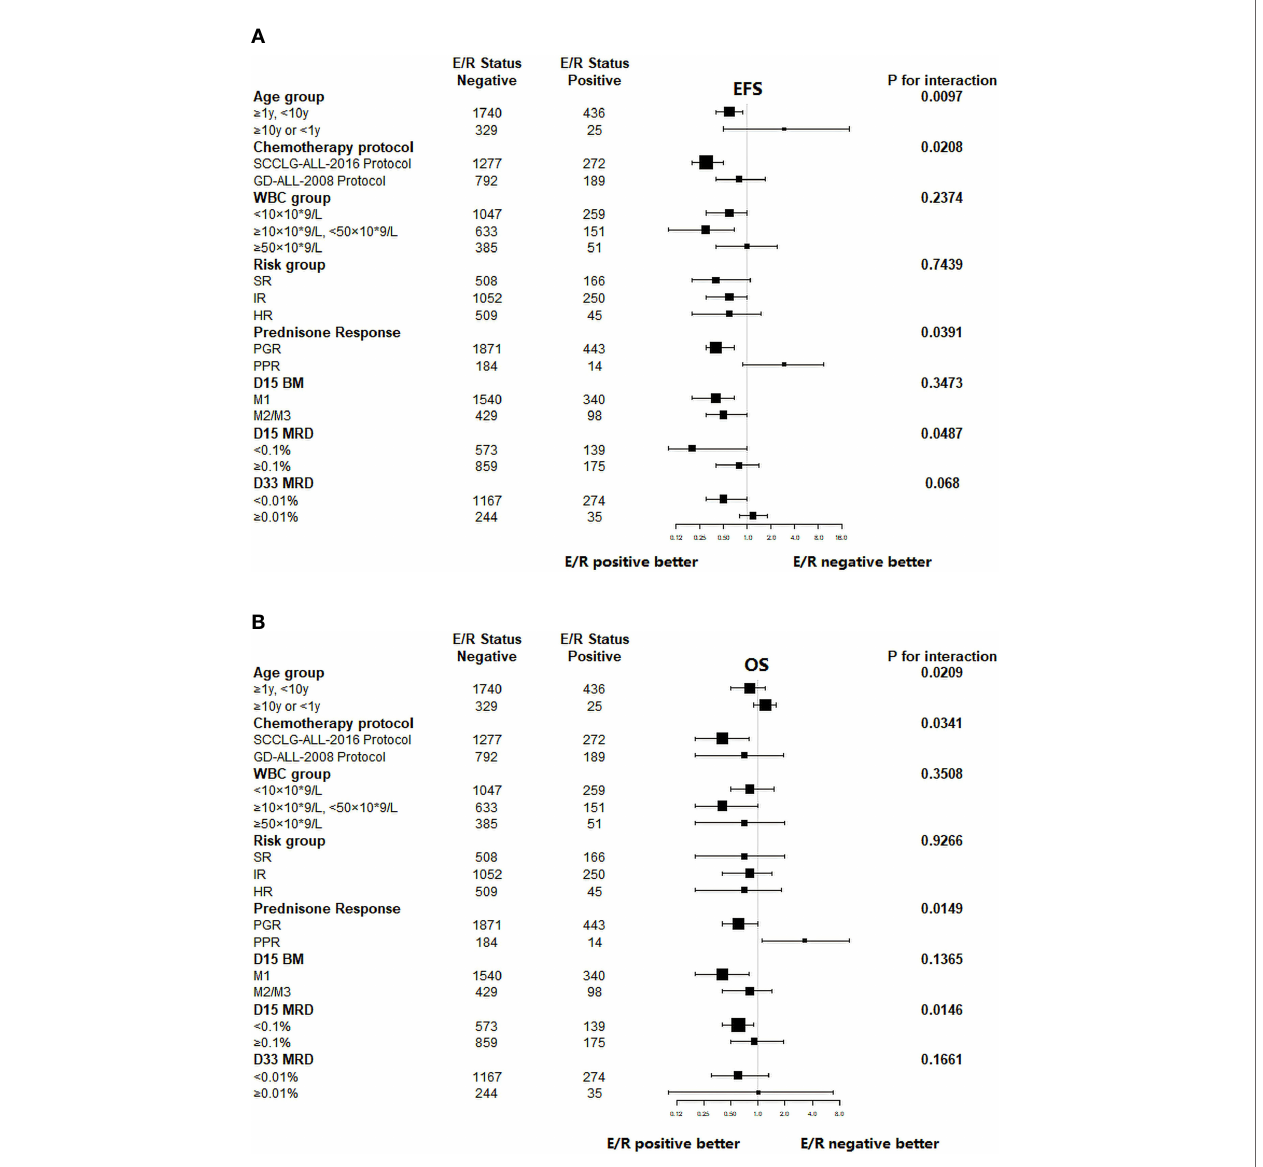
FIGURE 4 | Subgroup analysis of the associations between ETV6/RUNX1 status and outcome. (A) Hazard Ratios for EFS in pediatric patients in the ETV6/RUNX1- positive and ETV6/RUNX1-negative group according the risk factors. (B) Hazard Ratios for OS in pediatric patients in the ETV6/RUNX1-positive and ETV6/RUNX1- negative group according the risk factors. E/R for